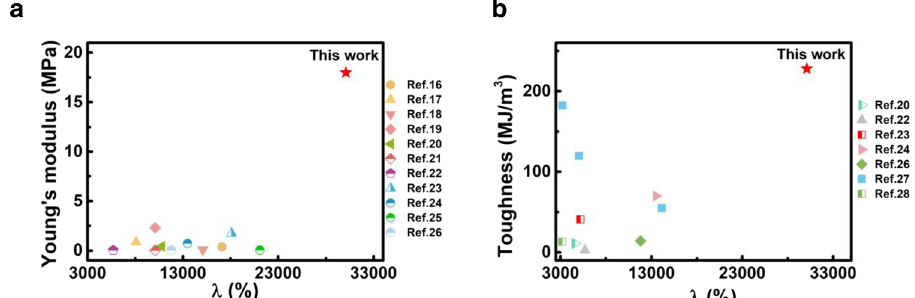
Fig. 1 Summary of reported superstretchable, stiff and tough polymers. a Ashby plot of “ Young ’ s modulus ” and " λ " of this work and other stretchable materials ( λ > 3,000%, λ = L/L 0 , L 0 is the initial length between the clamps, L is total length between the clamps). b Ashby plot of “ Toughness ” and " λ " of this work and other stretchable materials ( λ >